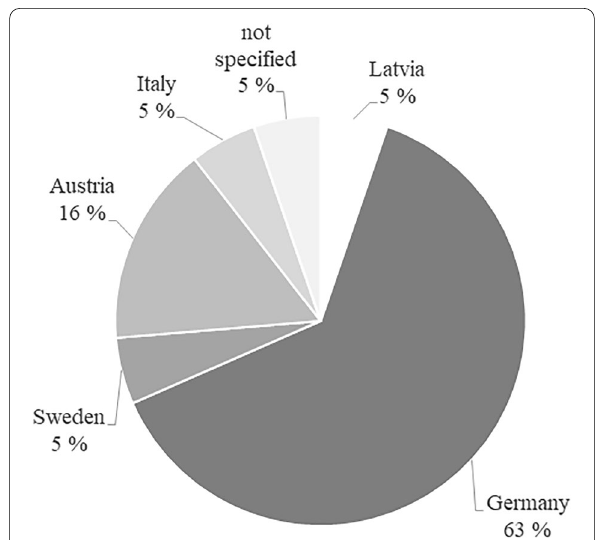
Fig. 5 Allocation by country for studies on CHP flexibilization, n